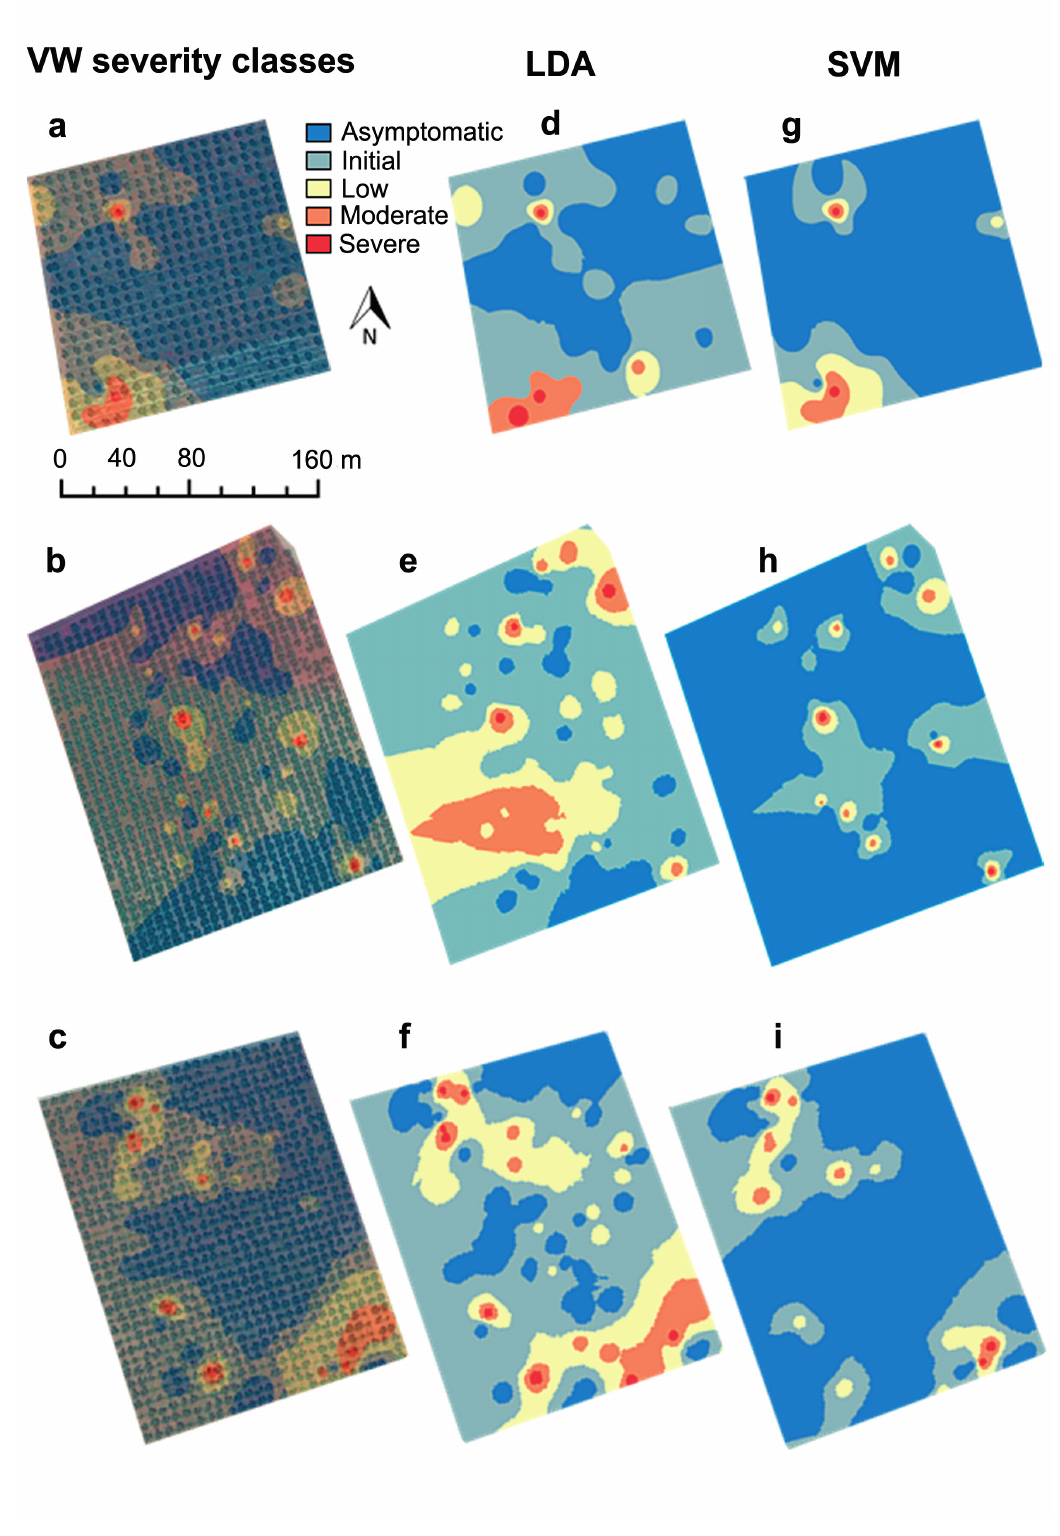
Figure 6. Spatial distribution of Verticillium wilt severity classes assessed at field level ( a , b , c ) and the severity classes predicted by the linear discriminant analysis (LDA) ( d , e , f ) and support vector machine (SVM) methods ( g , h , i ) in three different